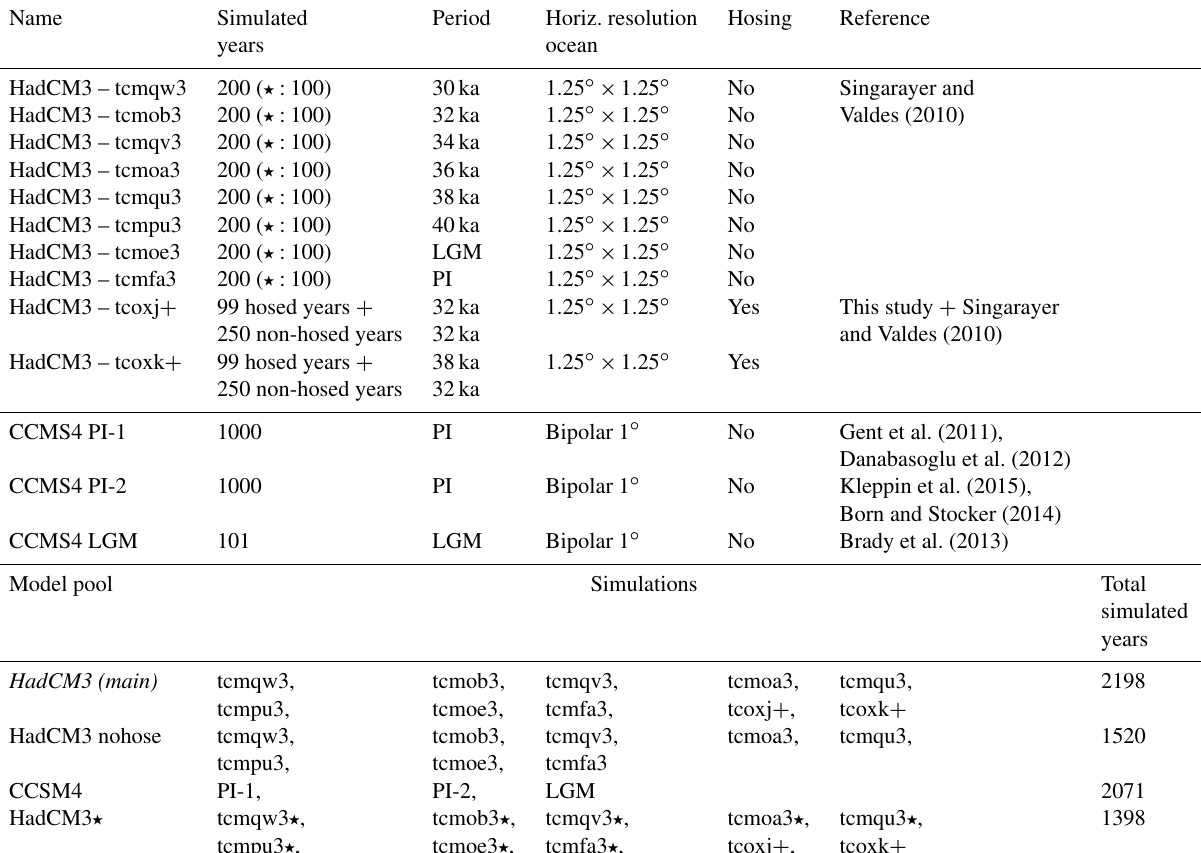
Table 2. GCM simulations.